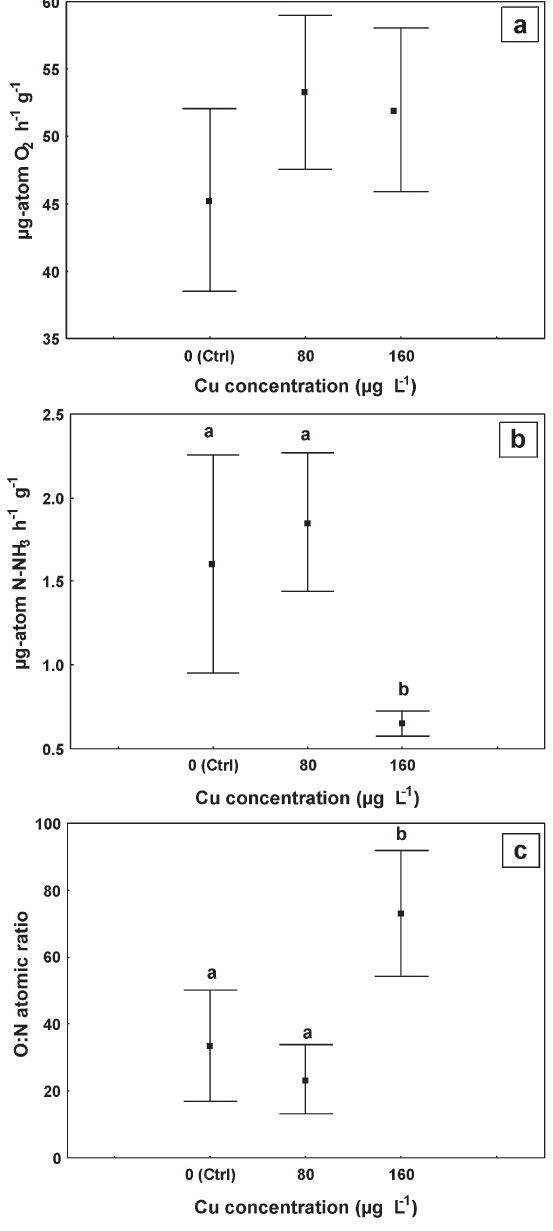
Fig . 2. – Oxygen consumption (a); ammonia excretion (b) and O:N atomic ratio (c) of Zoea I of Lithodes santolla exposed to copper. Mean ± S.D. Treatments sharing the same letters are not signifi- cantly different (ANOVA, p >0.05). (0 (Ctrl) = control group; 80 and 160 expressed as µg L -1 ; S.D. = standard deviation).